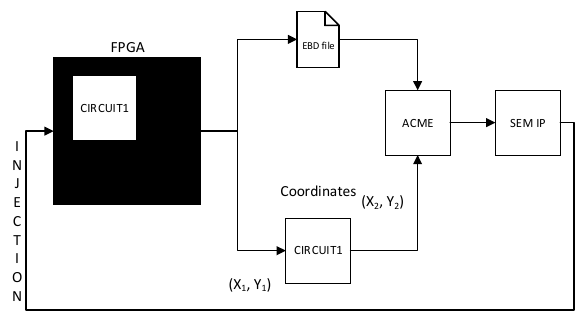
Figure 24. Integration of the ACME tool into fault injection process.